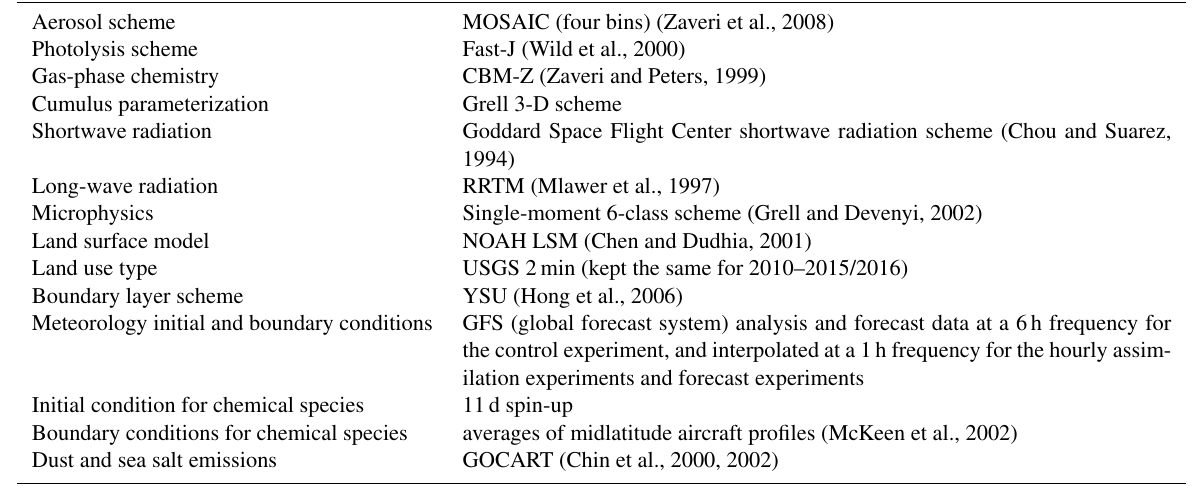
Table 1. WRF-Chem model